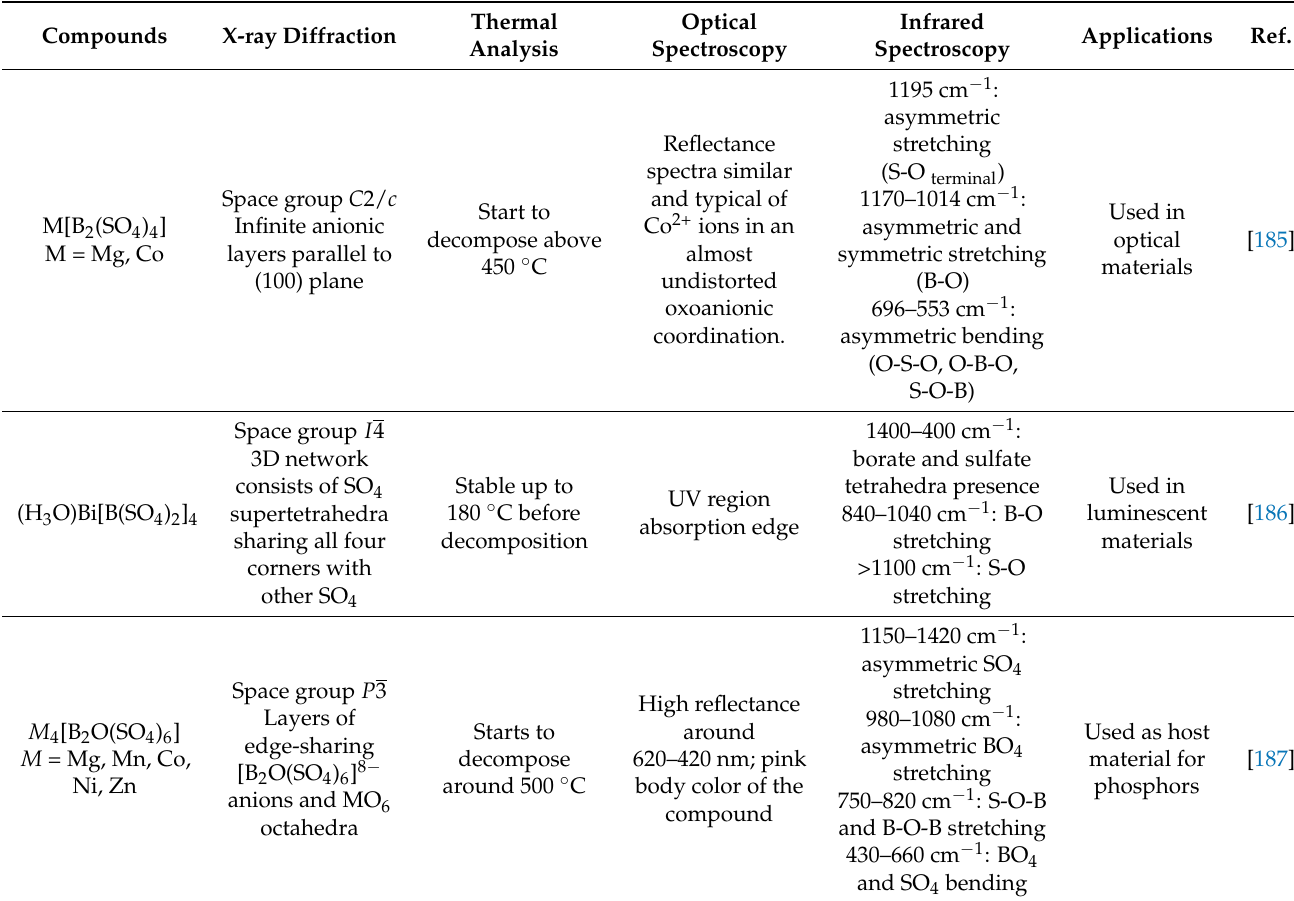
Table 9. Properties of different BSO known phases featuring earth-abundant